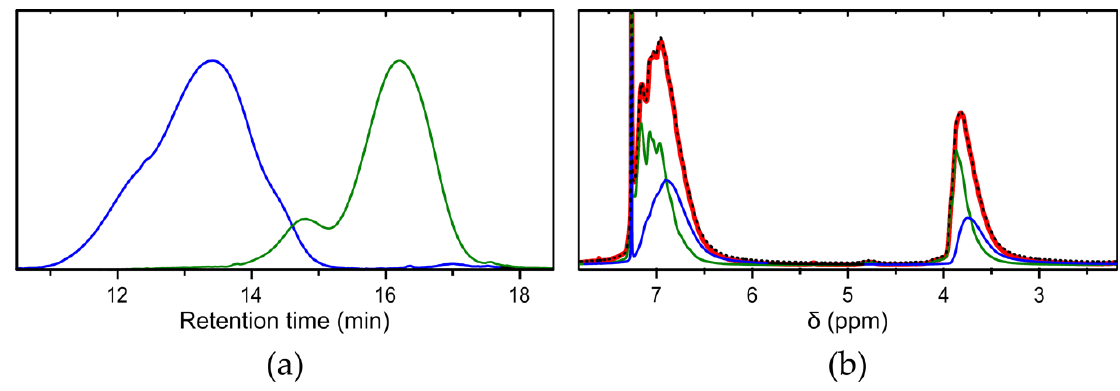
Figure 4. Separation of the trimodal distribution of the unfractionated PPM, synthesized with the catalyst [W 2 Br 4 (CO) 7 ], eventually into a high and a low molar mass fraction, denoted as F1 and F4 , respectively. ( a ) gel permeation chromatograms of the low molar mass fraction ( F1 , green), and the high molar mass fraction ( F4 , blue); ( b ) 1 H NMR spectra of the polymer P before fractionation (red) and the fractions F1 and F4 . Also included is the composed spectrum of the fractions according to their fractional yield (black dashed line).